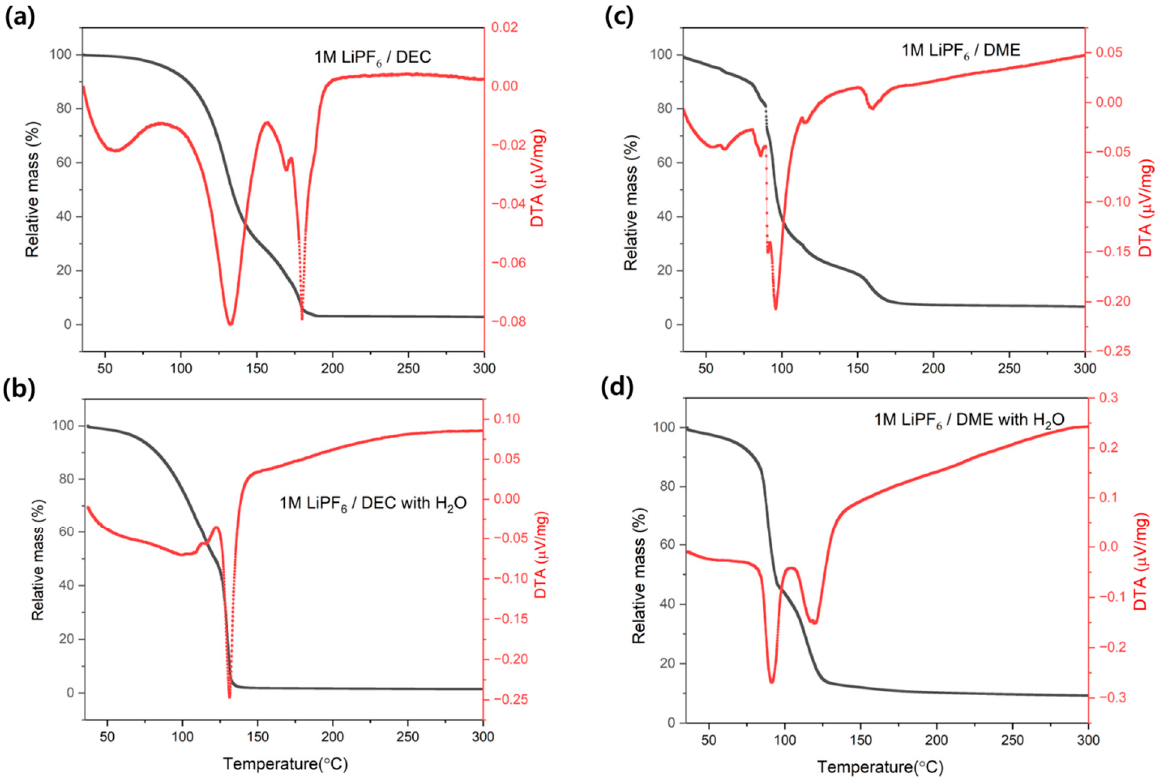
Figure 1. TG/DTA curves of each 1 M electrolyte solution without water (upper) and with added water (lower). ( a ) 1 M LiPF 6 /DEC electrolyte without water, ( b ) 1 M LiPF 6 /DEC electrolyte with added water, ( c ) 1 M LiPF 6 /DME electrolyte without water, and ( d ) 1 M LiPF 6 /DME electrolyte with added